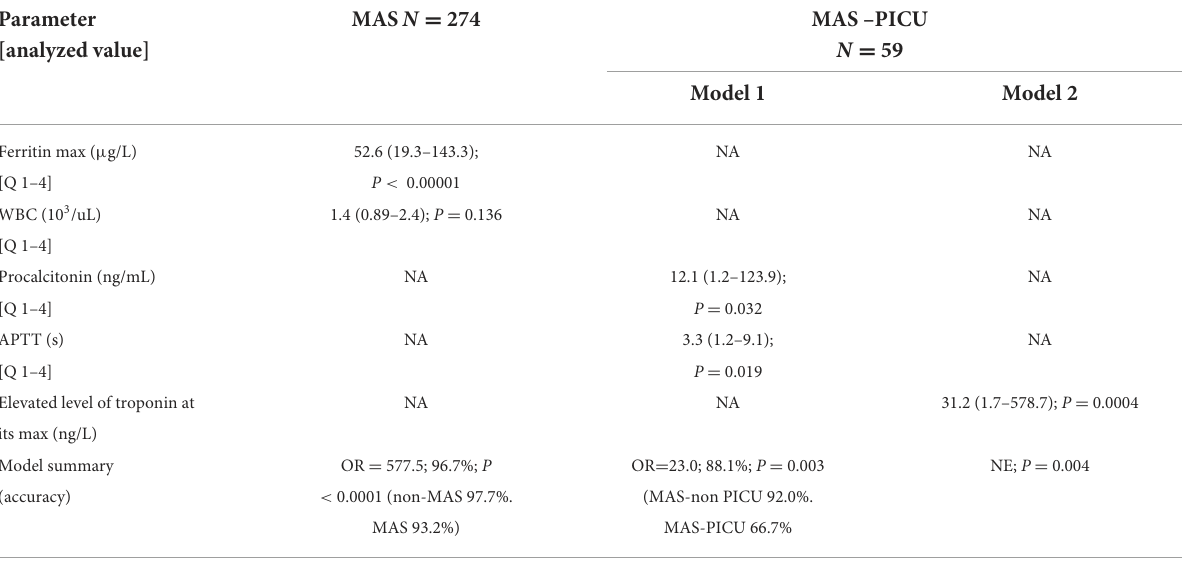
TABLE 3 Multivariate analysis of the association between laboratory results at respective peaks and the presence of macrophage activation syndrome (MAS) and MAS requiring pediatric intensive care unit (PICU) hospitalization (MAS-PICU) in 274 patients meeting MIS-C criteria.